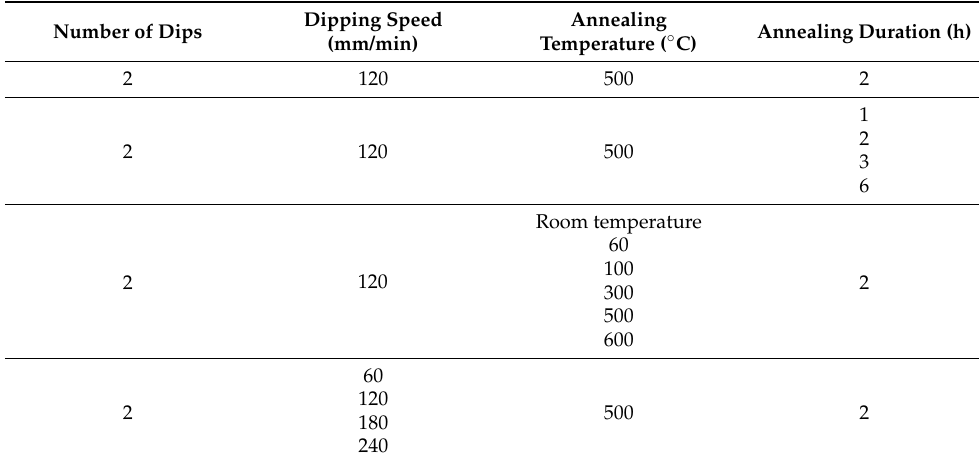
Table 2. List of evaluated conditions for thin film deposition on glass. The reference one is reported in italic as first